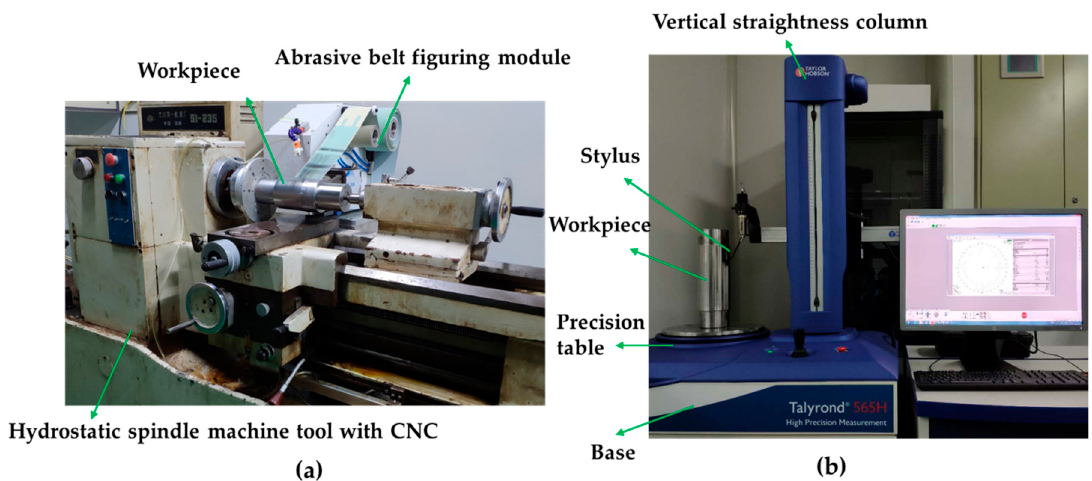
Figure 6. Machining and measuring device: ( a ) The abrasive belt-based figuring device; ( b ) the cylindricity measuring instrument.